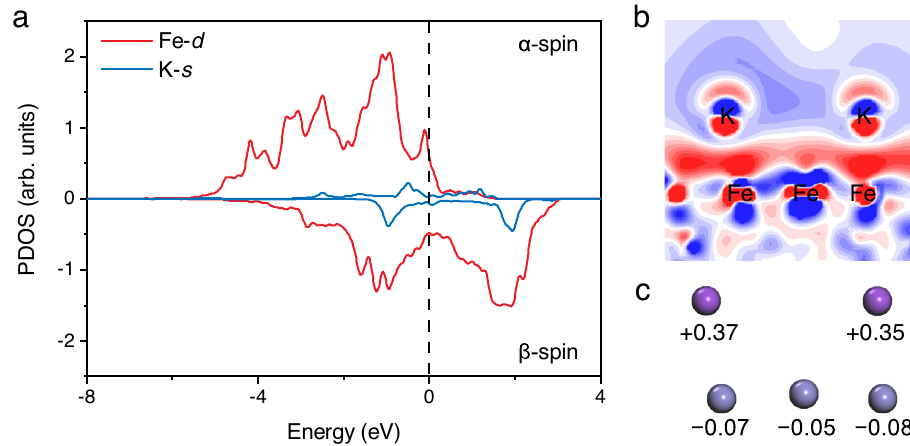
Fig. 4 | Theoretical study on the electronic effect between Fe and K. a Partial density of states (PDOS) of Fe(110)-K, including the Fe- d orbits and adjacent K- s orbits. b Corresponding charge density difference between Fe and K. c the Hirsh- feld charge analysis. Color codes in the cartoon: purple and gray are K and Fe,